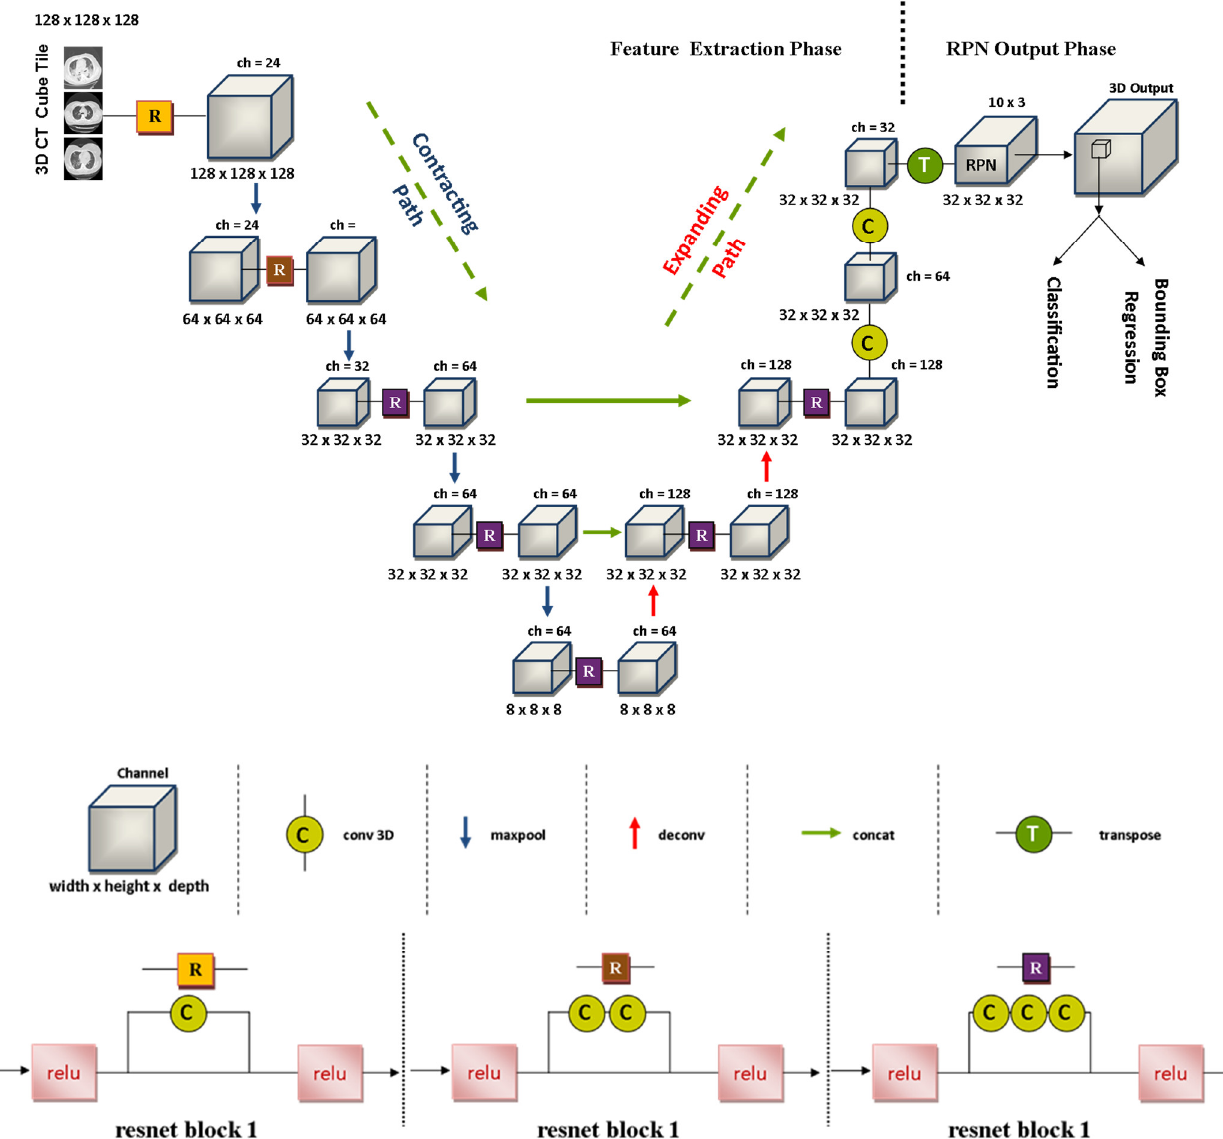
Figure 5. Block Structure of the VNET-RPN Network.